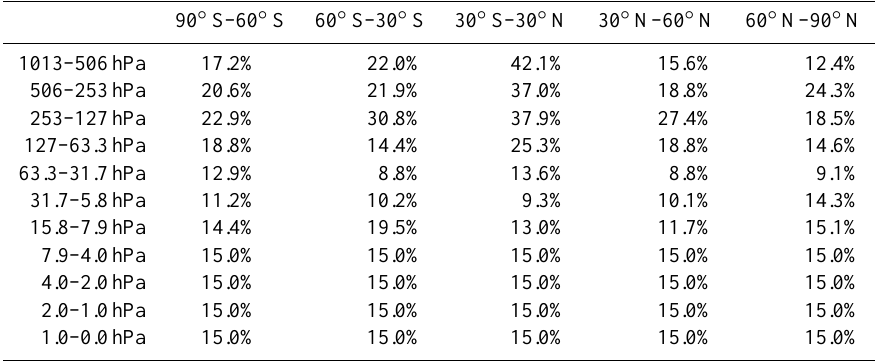
Table 2. TOMS climatology variability for 11 layers and 5 latitude